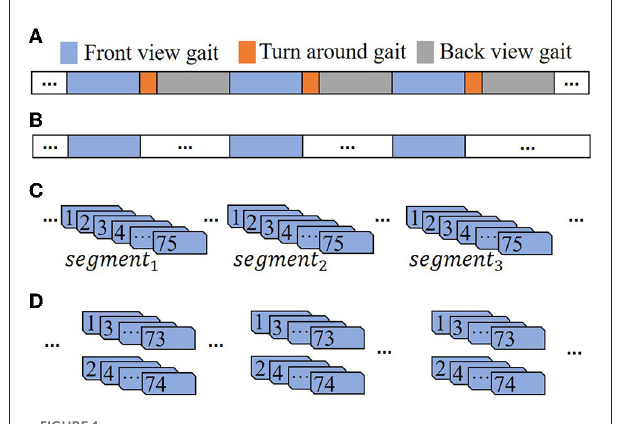
FIGURE1 Gait video data segmentation process. (A) Full gait video. (B) Only the front-view gait segments of the video are kept. (C) Keep 75 frames. (D) Split odd and even frame segments.